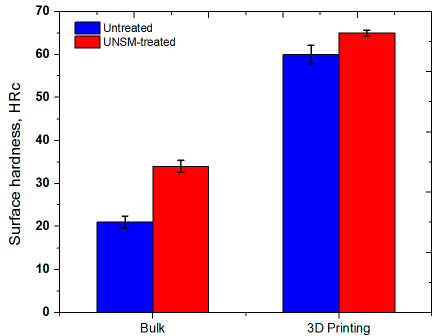
Figure 6. Comparison of surface hardness of the bulk and 3D-printed AISI H13 tool steel specimens before and after UNSM treatment.